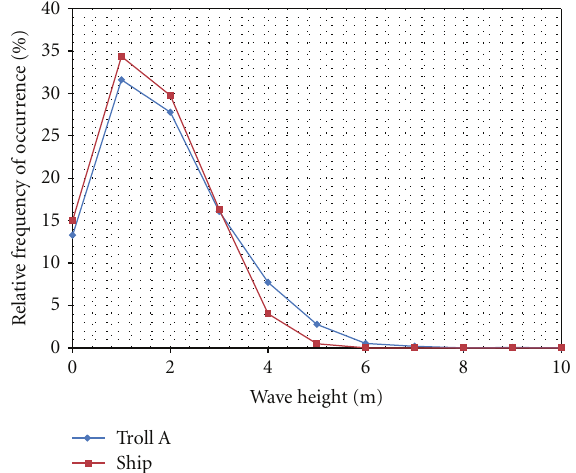
Figure 31: Comparison of Troll A and test ship wave significant height relative frequency of occurrence.